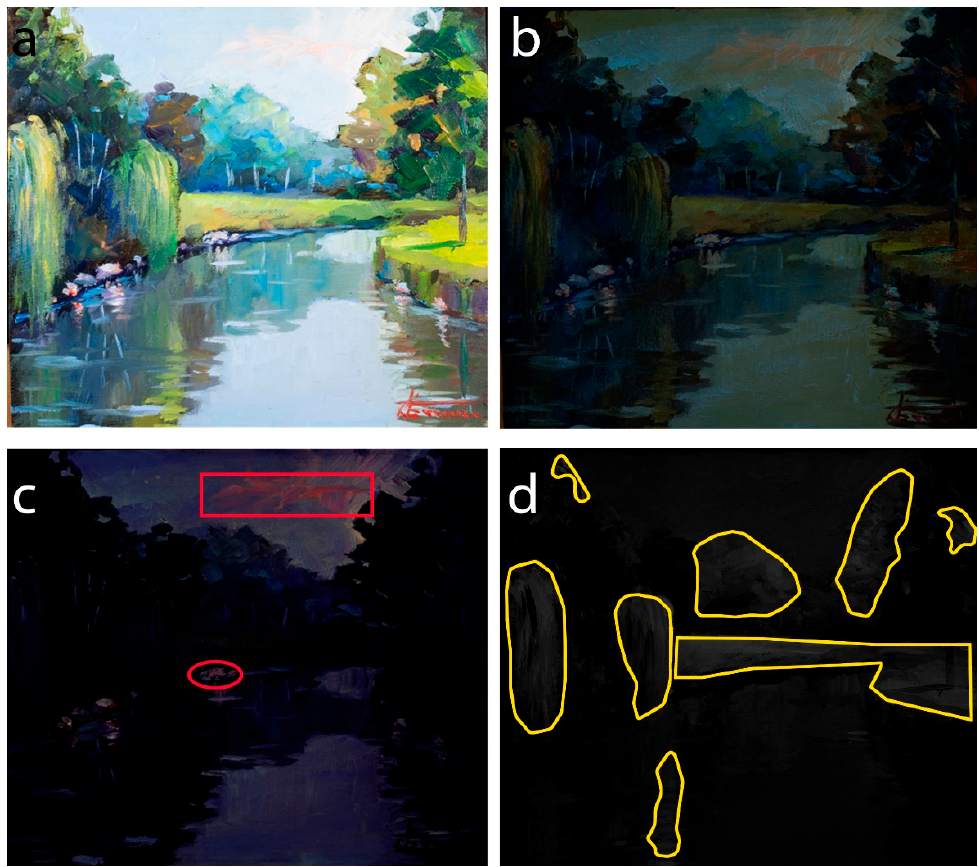
Figure 11. ( a ) Visible image of the painting “Addetta near Zoate” (G. Faraone, 2011); ( b ) UVF image; ( c ) VIVF image (exc 440 nm); ( d ) VIL image (exc 440 nm). ( c ) VIVF image (exc 440 nm); ( d ) VIL image (exc 440